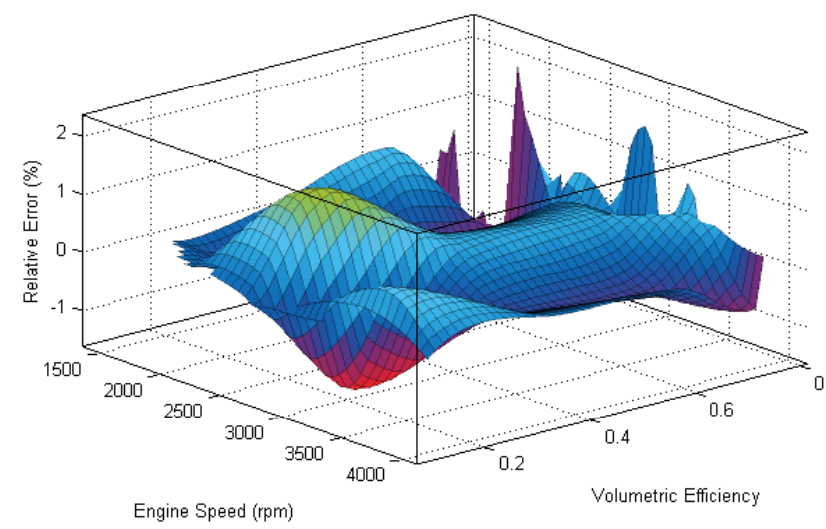
Figure 12. Relative error of the exhaust temperature predicted by the model.